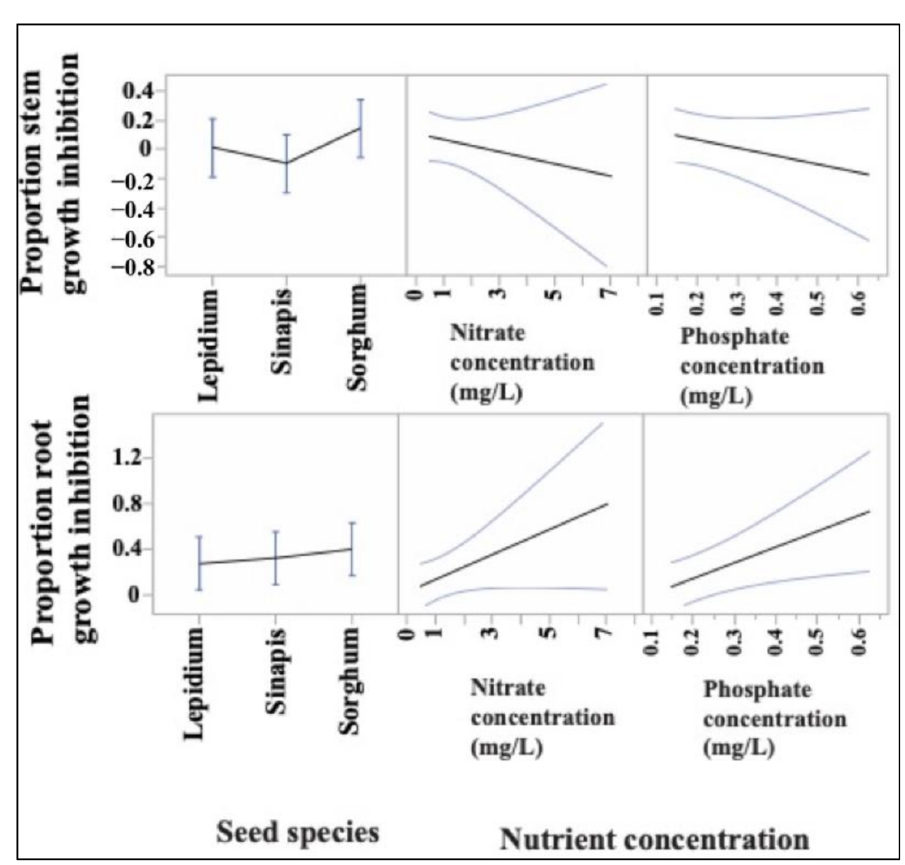
Figure 3. Prediction profiles from ANOVA showing the effects of seed species, nitrate and phosphate concentrations (mg/L) measured in wetlands on the growth inhibitions of the bioindicator species Lepidium sativum , Sinapis alba and Sorghum saccharatum . The blue-lined area in each profile represents the 95% confidence prediction interval of the y (continuous) variable). The profiler was set to nitrate at 2.27 mg/L and phosphate at 0.29 mg/L in case of root and stem growth inhibition. The effects of metal concentrations on ecotoxicological bioindicator growth inhibi- tions were also examined through ANOVA, using component scores calculated from the factor analysis (Figure 2). None of the metal components had a statistically signif- icant effect on stem growth inhibition with p values for metal component 1 = 0.3511, component 2 = 0.8892, and interaction of components = 0.5697 (Figure 4). However, seed species did respond significantly ( p = 0.